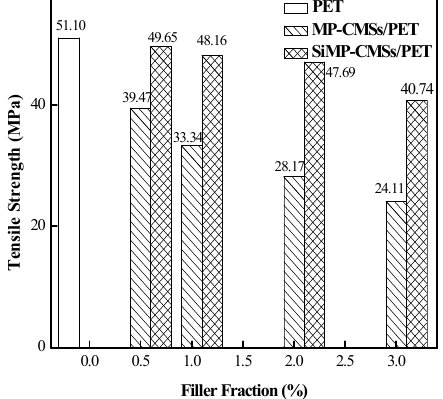
Figure 12. Tensile Strength of the SiMP-CMSs/PET composites.